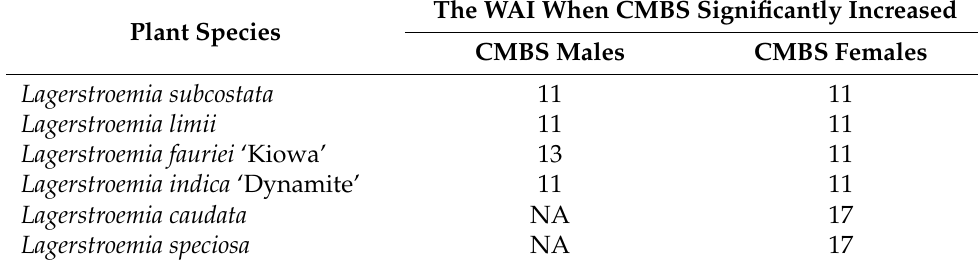
Table 3. The weeks after inoculation (WAI) when the number of Acanthococcus lagerstroemiae males or females increased significantly compared to the previous week on different Lagerstroemia